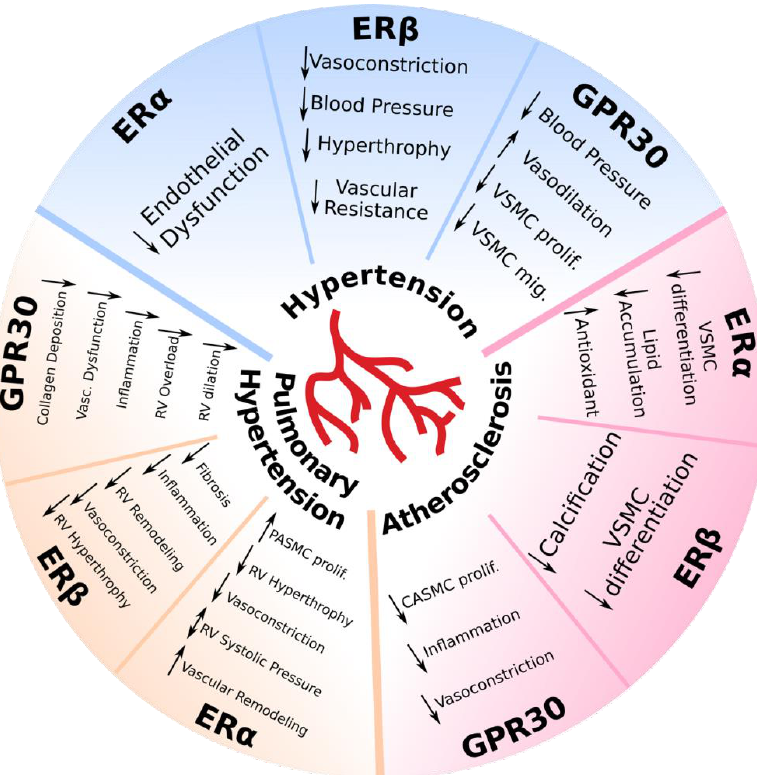
Figure 1. The role of estrogen receptors in vascular disease: hypertension, pulmonary hypertension, and atherosclerosis. Depicted pathways have been shown to be involved in animal models of cardiovascular disease. CASMC: coronary artery smooth muscle cells; ERα: estrogen receptor alpha; ERβ: estrogen receptor beta; GPR30: G-protein-coupled estrogen receptor; Mig: migration; PASMC: pulmonary artery smooth muscle cells; Prolif: proliferation; RV: right ventricular; Vasc: vascular; VSMC: vascular smooth muscle cells; ↑ : increased; ↓ : decreased; (cid:108) : conflicting